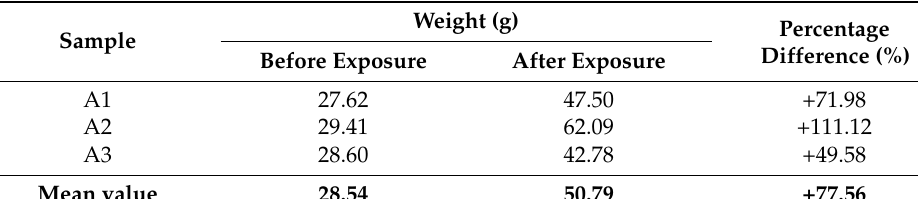
Table 4. Summary of weight measurement values before and after environmental exposure.